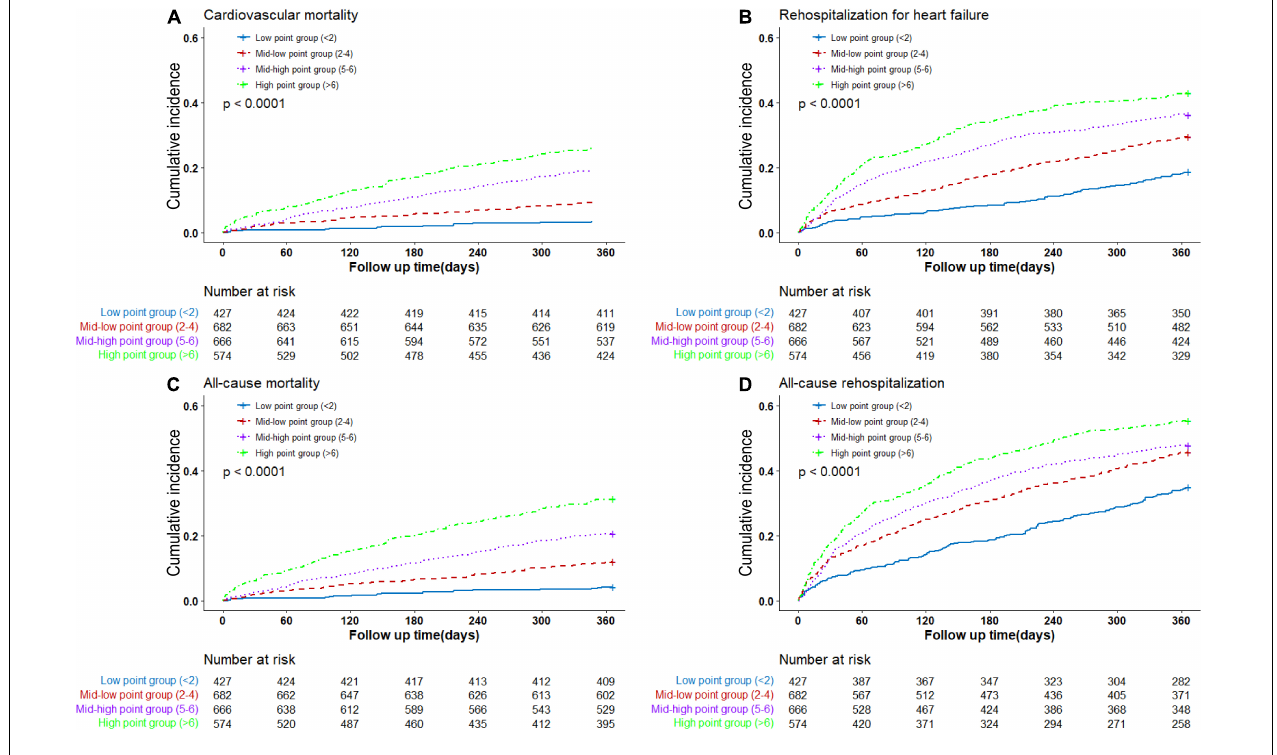
FIGURE 2 | Cumulative event rates by multi-biomarker groups (validating cohort). (A) Rates of cardiovascular death by groups. (B) Rates of rehospitalization for heart failure by groups. (C) Rates of all-cause death by groups. (D) Rates of all-cause rehospitalization by